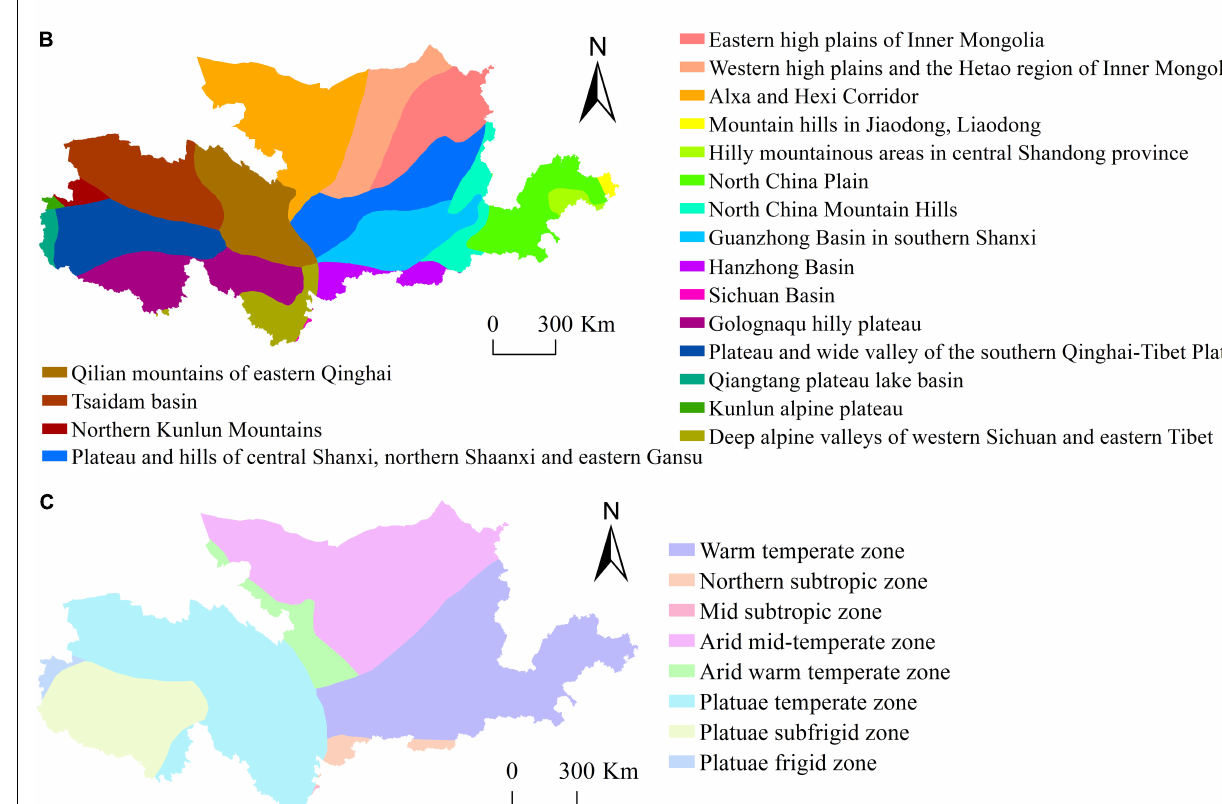
Frontiers in Ecology and Evolution |